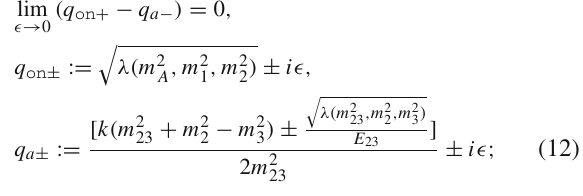
( 3872 ) meson, following earlier ideas [36,37] X ∼ χ c 1